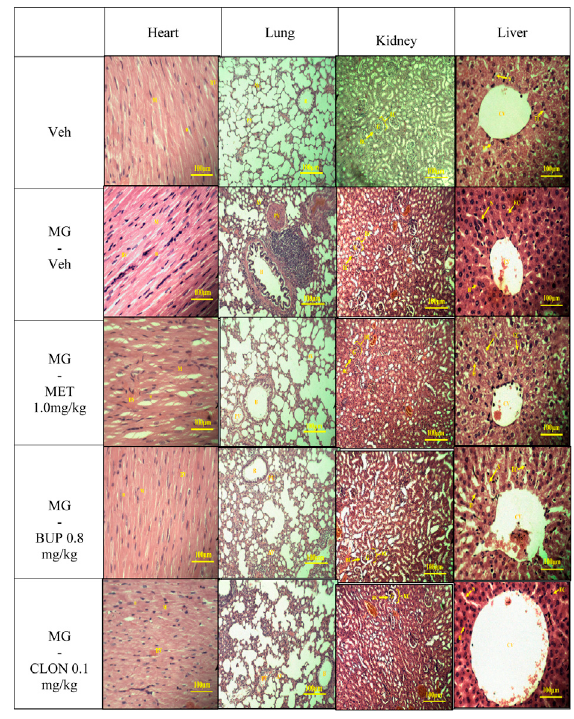
TABLE 4 | The microscopic structures of the organs in mitragynine replacement